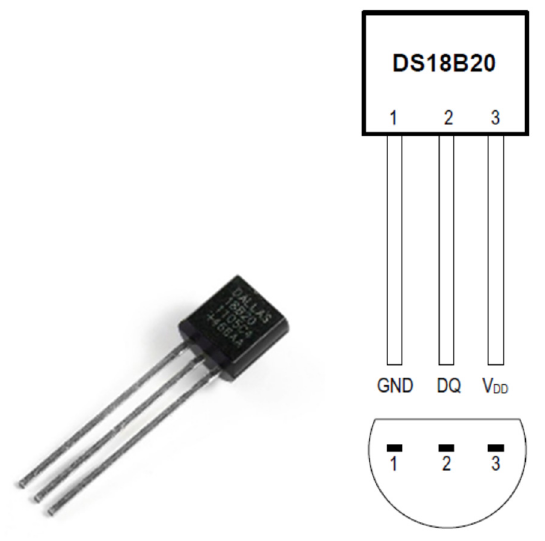
Figure 7. DS18B20 features [60].